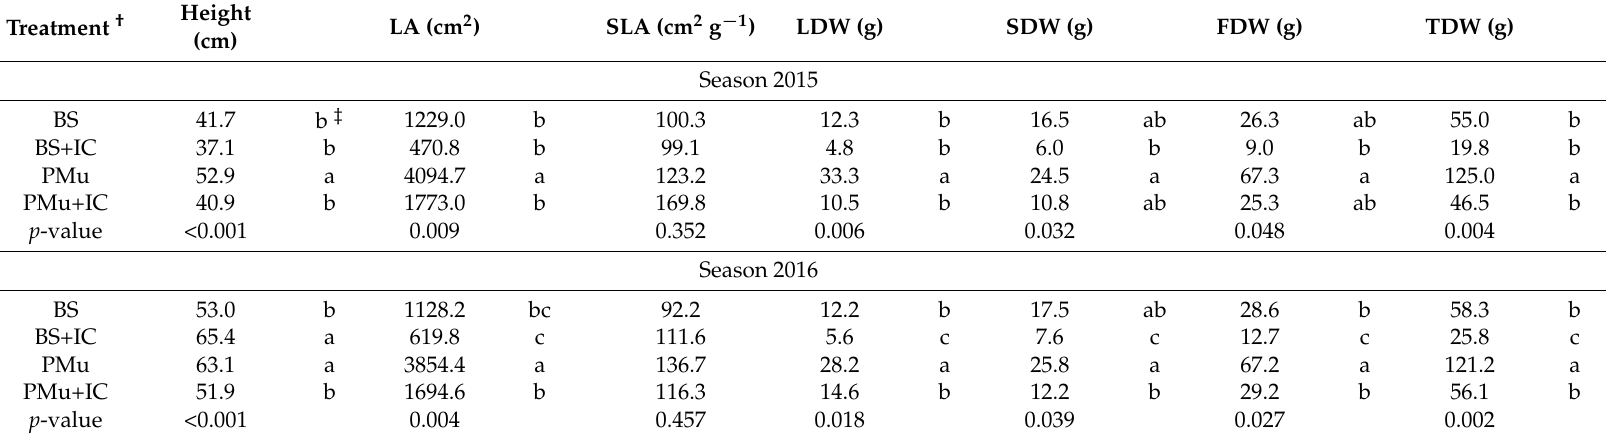
Table 3. Jalapeño pepper height, leaf area (LA), specific leaf area (SLA), leaves dry weight (LDW), stems dry weight (SDW), fruit dry weight (FDW), and total dry weight (TDW) as affected by mulching and intercropping, during two growing